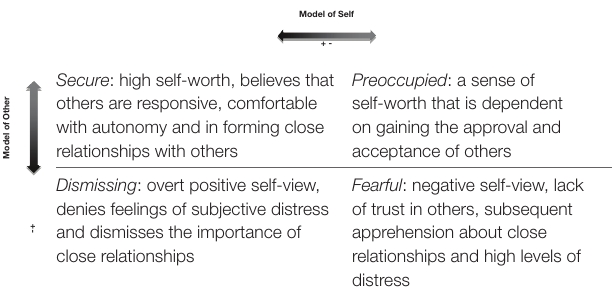
Table 2 | Adult attachment style according to Bartholomew and Horowitz’s model.